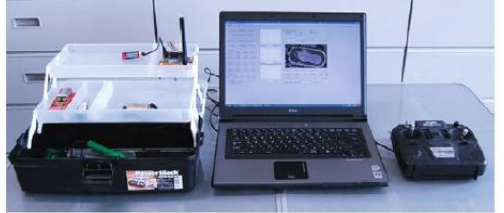
Figure 8. Ground control station set up